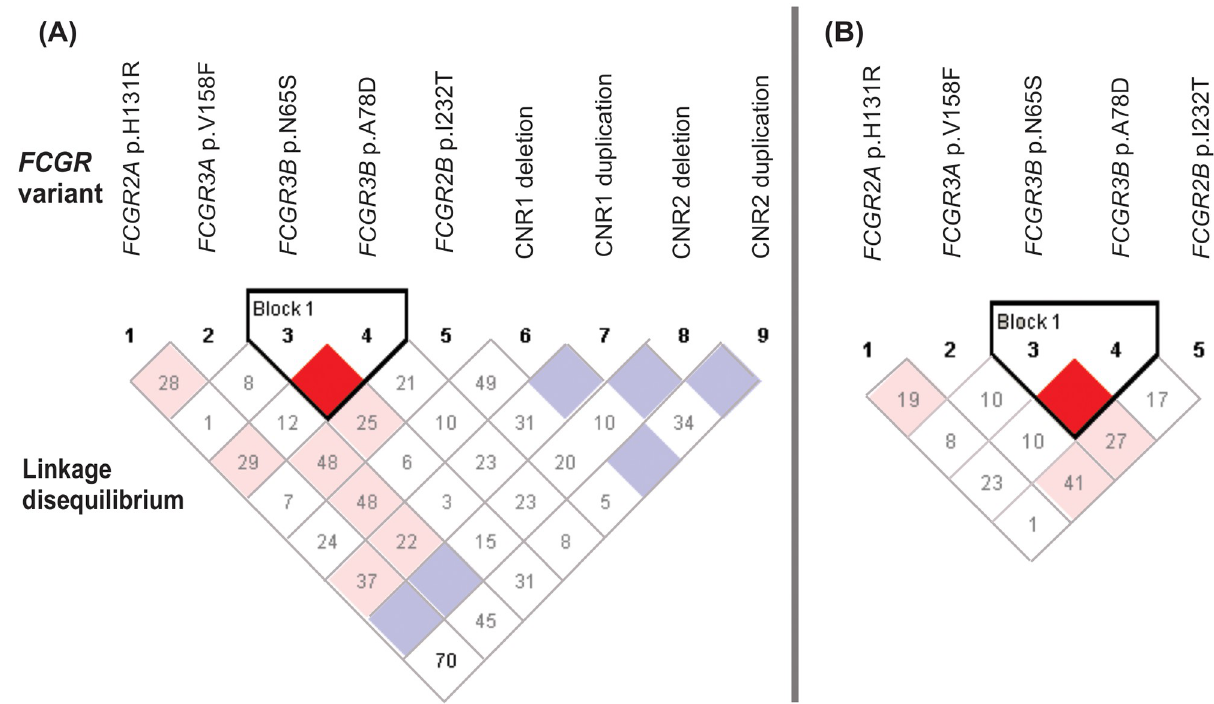
Fig 2. Linkage disequilibrium of functional FCGR variants in South African children born to women living with HIV-1. (A) All individuals, with or without CNV (n = 707); (B) only individuals with two gene copies (n = 474). The black triangle illustrates a haplotype block. Values reflect D 0 measures of LD and colour in the squares given by standard D 0 divided by log of the odds of LD between two loci (LOD). Bright red colour indicates very strong LD.